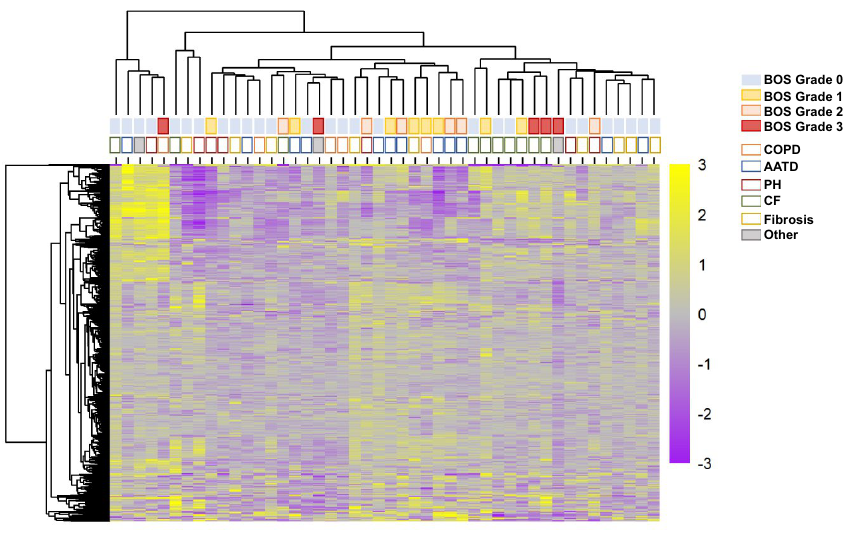
Figure 1. Heatmap of All Unique Proteins. Proteins detected using the proximity extension assay were placed on a logarithmic scale and NPX values were set to zero. Positive values indicate NPX levels above detection and increased compared to the average scaled NPX value for patients with BOS grade 0. Proteins detected in more than 15% of samples were included and then clustered using Euclidean distances. Assigned colors report both the BOS grade (top row) and well as the underlying diagnosis of each included patient (second row). COPD, chronic obstructive pulmonary disease; AATD, alpha-1 antitrypsin deficiency; PH, pulmonary hypertension; CF, cystic fibrosis; BOS, bronchiolitis